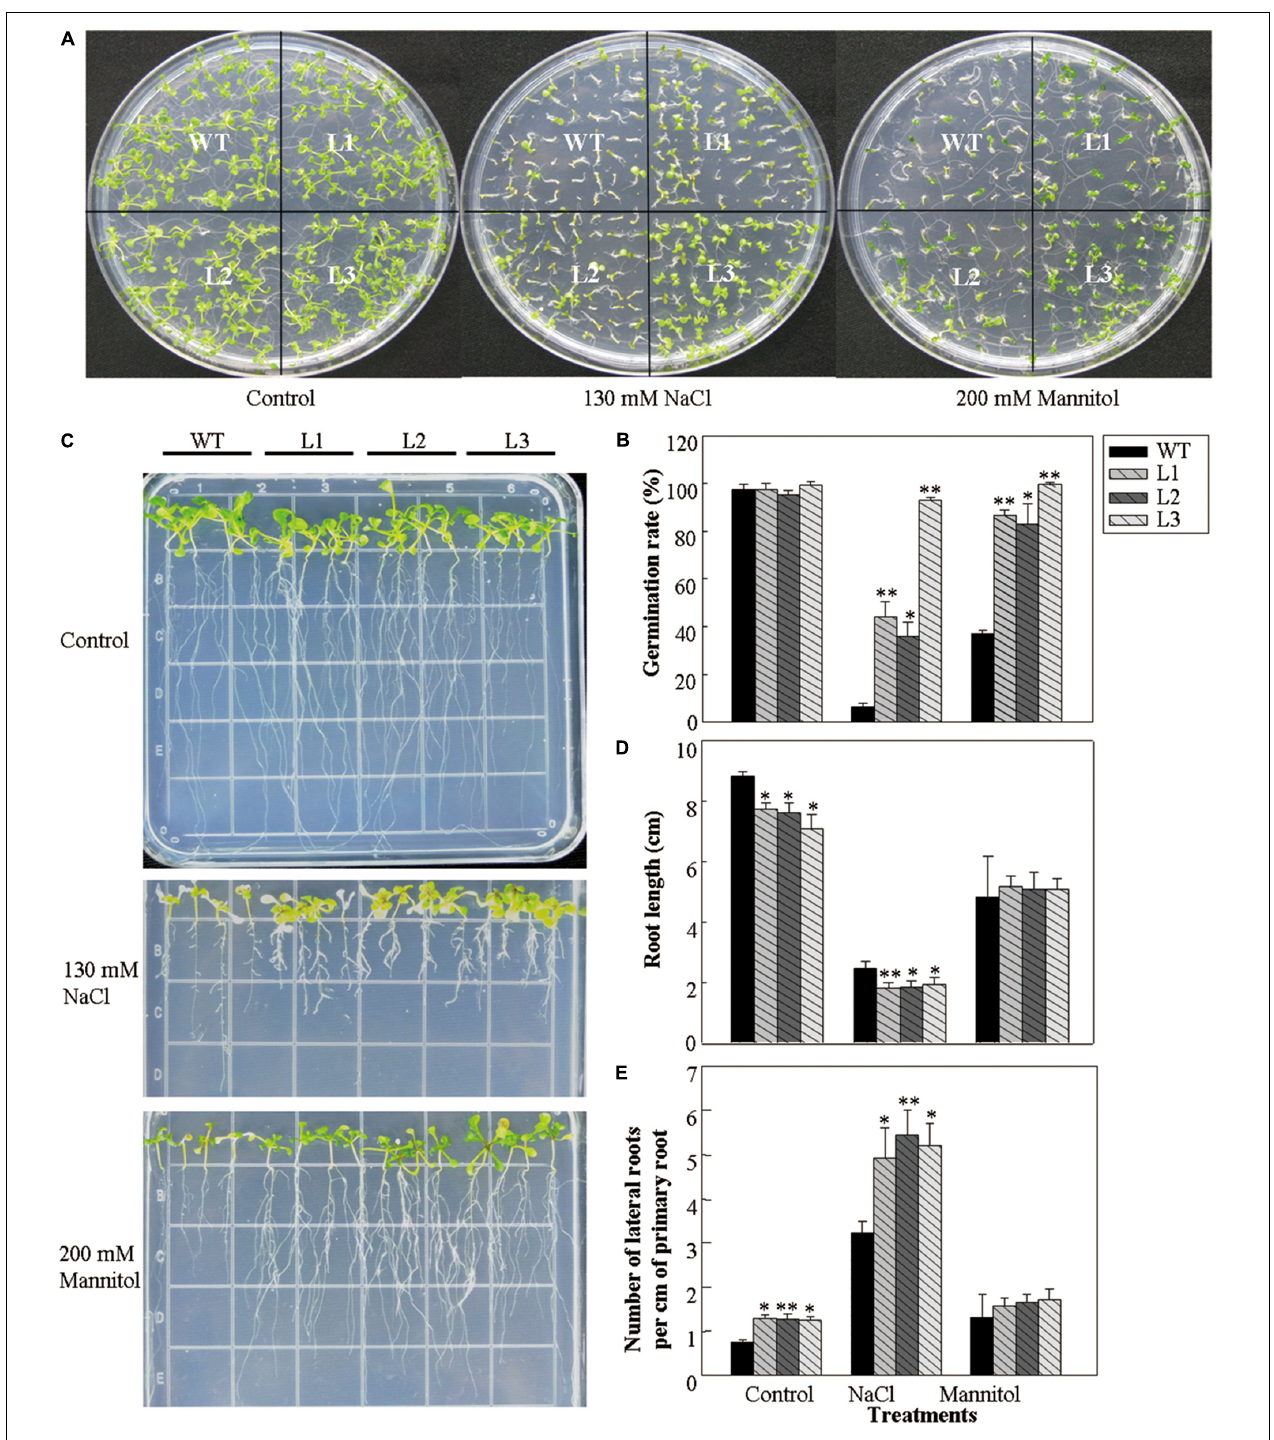
FIGURE 1 | Effect of osmotic stress on seed germination and post-germination growth of WT and VlWRKY3 transgenic Arabidopsis thaliana lines. (A) WT and transgenic seedlings 10 days after seeds were sown on Murashige and Skoog (MS) medium or MS basal medium supplemented with 130 mM NaCl and 200 mM mannitol. (B) Germination rates of seeds sown on MS, MS + 130 mM NaCl, or MS + 200 mM mannitol plates. Each data point is the mean of three replicates of 100–120 seeds. (C) Seedlings at 15 days after transfer to MS, MS + 130mM NaCl, or MS + 200 mM mannitol plates. Seedlings were 5-days-old at the time of transfer. (D,E) Root length (D) and lateral root number (E) of WT and transgenic lines after 15 days treatment with or without 130 mM NaCl and 200 mM mannitol. Each data point is the mean of three replicates of 20–30 seedlings. The error bars indicate the SD. Asterisks indicate statistical significance ( ∗ 0.01 < P < 0.05, ∗∗ P < 0.01, Student’s t test) of differences between transgenic lines and WT seedlings.